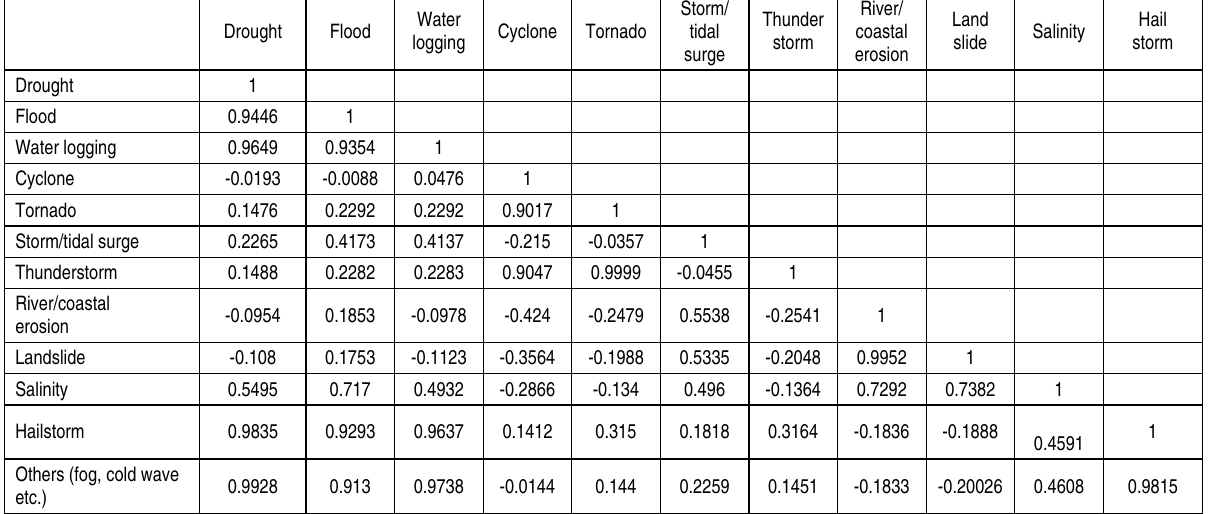
Table 8. Correlation matrix of different categories of catastrophes affected on